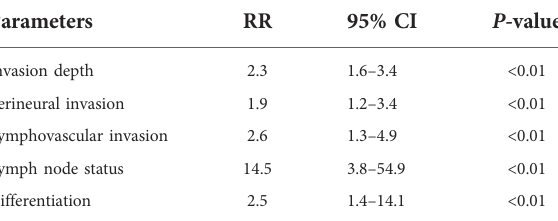
TABLE 6 Multivariate analysis of lymph node (#13, #17, #12, and #8) status on survival in patients with ampullary adenocarcinoma.